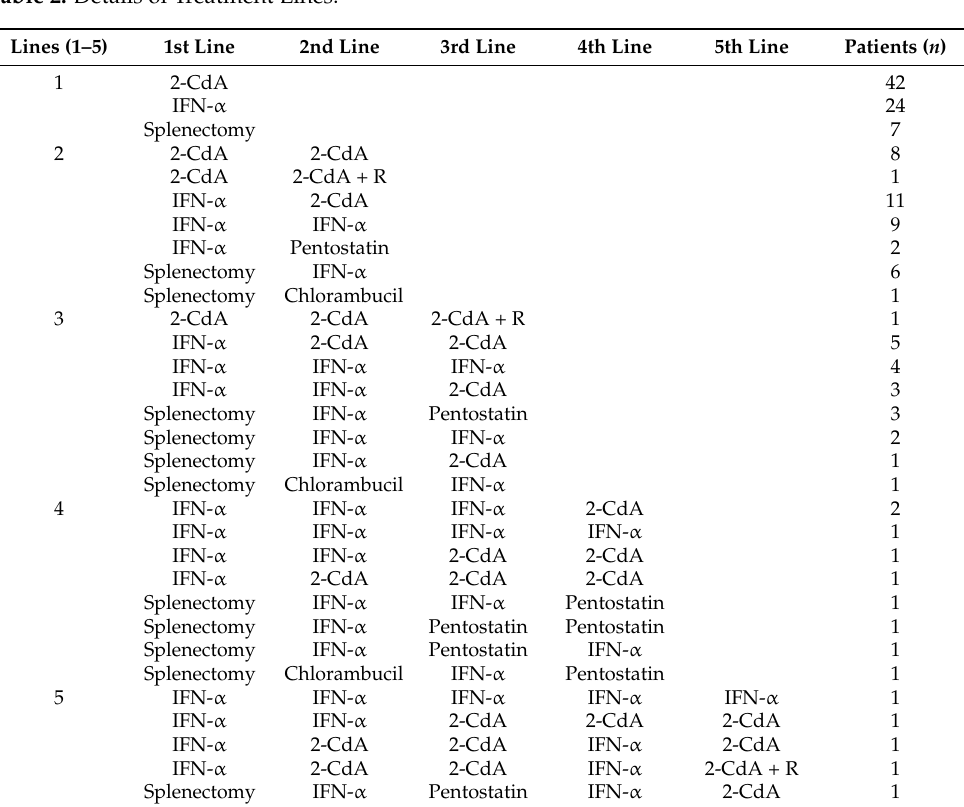
Table 2. Details of Treatment